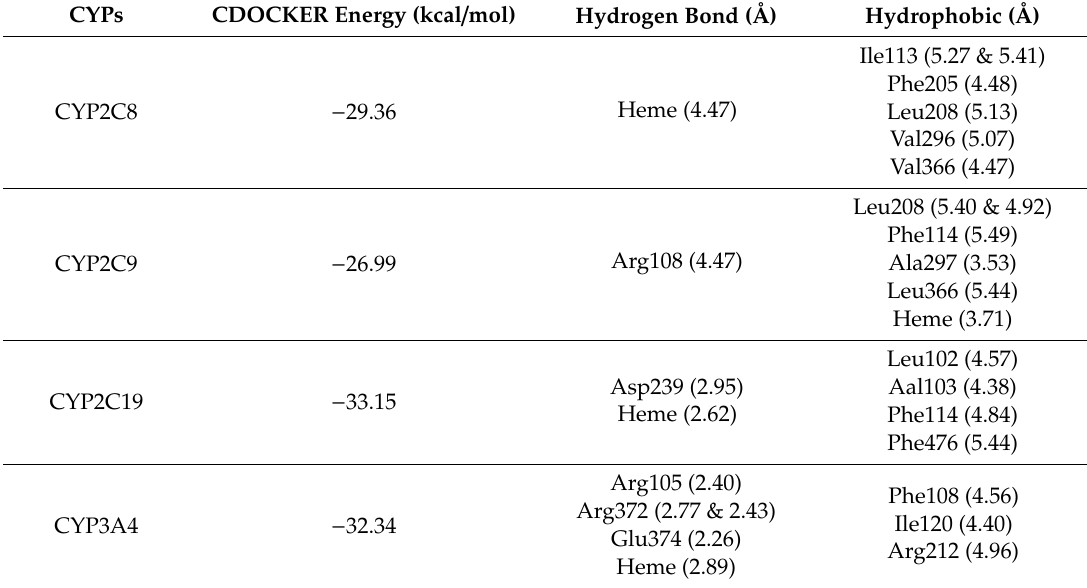
Table 3. Interactions between AB-PINACA and human CYP2C8, CYP2C9, CYP2C19, and